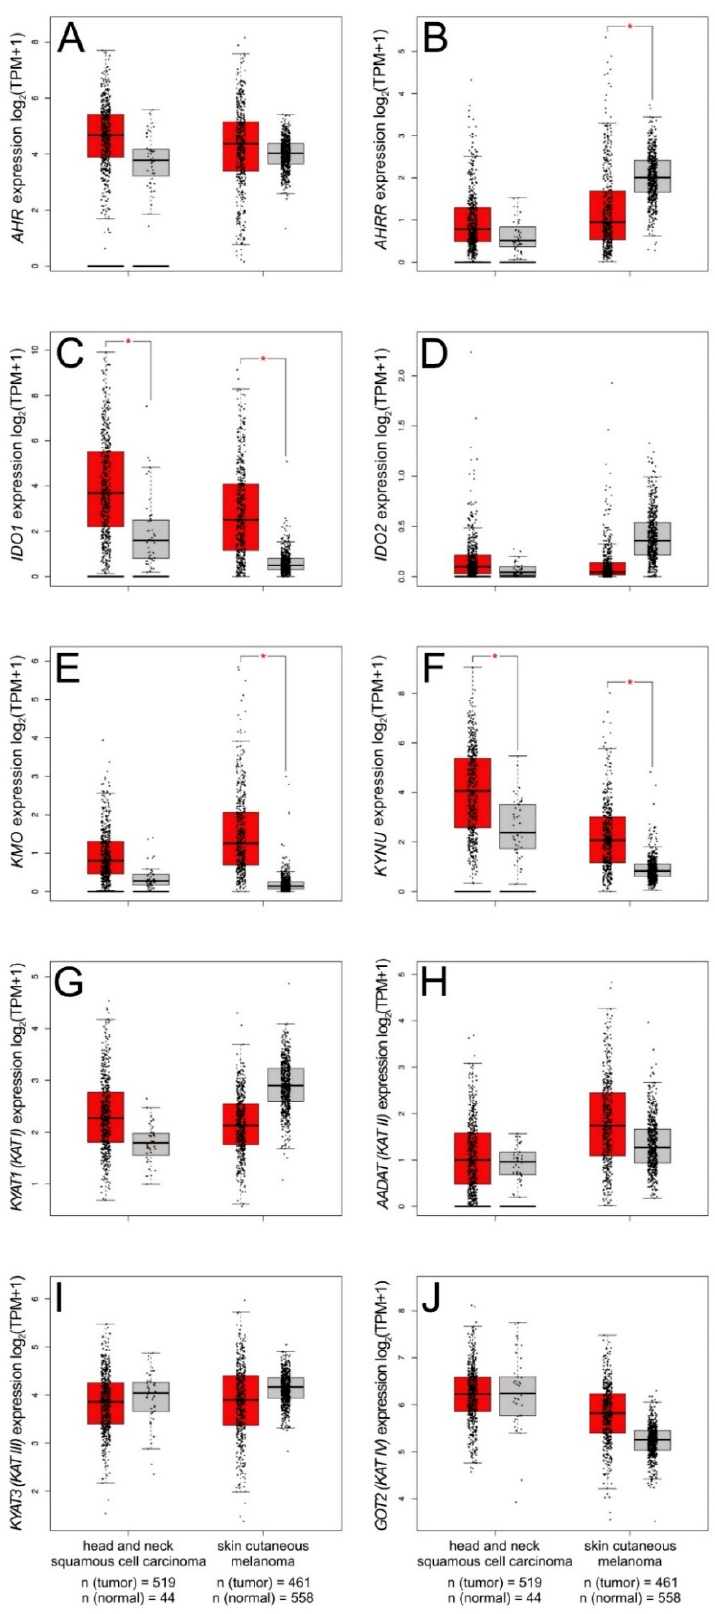
Figure 3. Expression pattern of genes encoding AHR ( A ), AHRR ( B ), tryptophan catabolizing enzymes ( IDO1 ( C ), IDO2 ( D ), KMO ( E ), KYNU ( F )) and kynurenine aminotransferases ( KAT I–IV ( G – J )) in human head and neck squamous cell carcinoma and skin cutaneous melanoma. Expression of